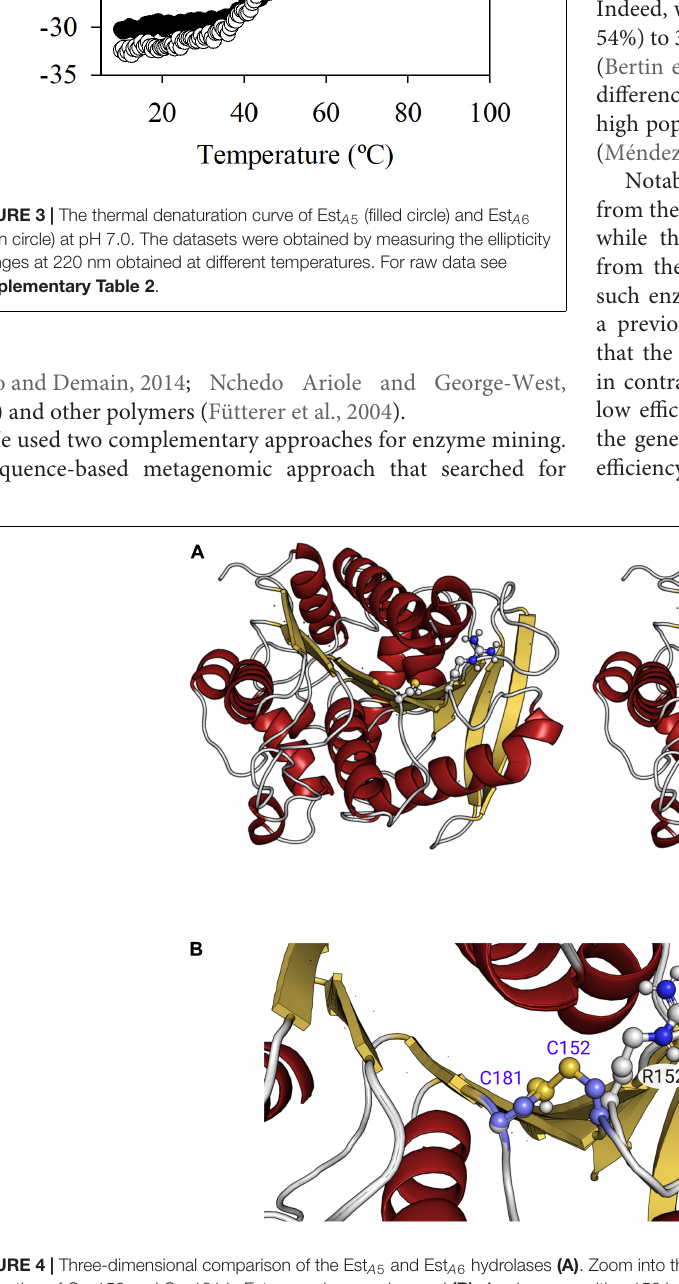
FIGURE 4 | Three-dimensional comparison of the Est A 5 and Est A 6 hydrolases (A) . Zoom into the region that is different between both proteins, where the possible interaction of Cys152 and Cys181 in Est A 6 can be seen in panel (B) . As shown, position 152 is occupied by Arg in Est A 5 instead. Figure has been created using PMOL(TM)